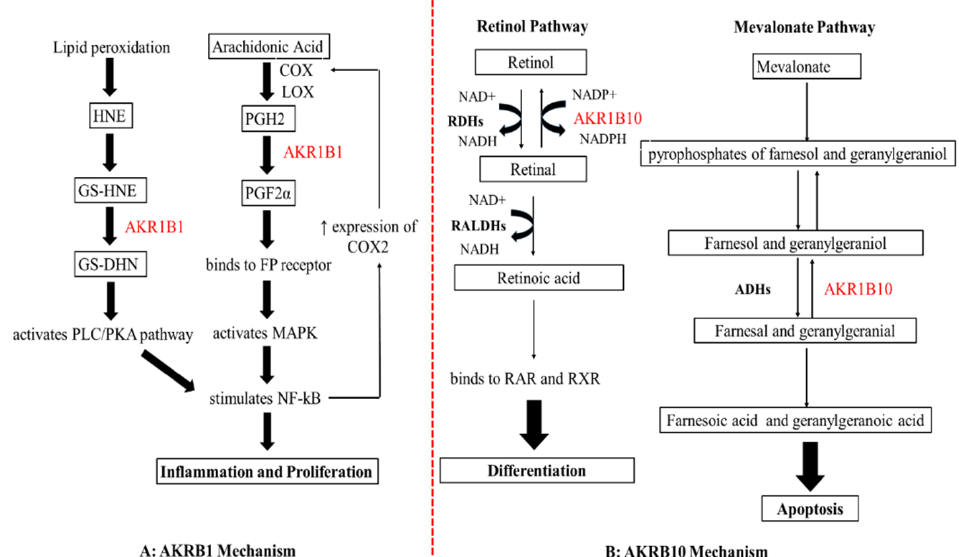
Figure 1. Correlation between inflammation mechanism and aldo-keto reductases (AKR1B1,